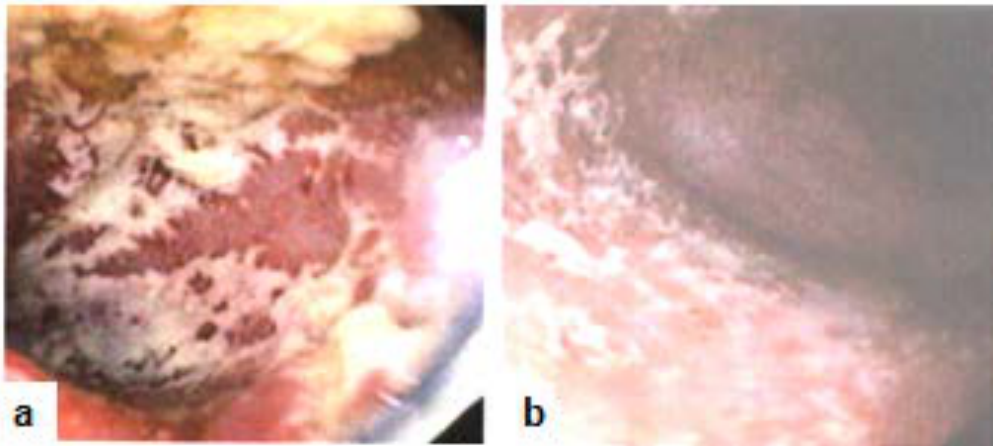
Figure 1. Colonoscopy (2010) with image representatives. ( a ) Rectum: Ulcerative colitis; ( b ) Sigmoid colon: Ulcerative colitis.